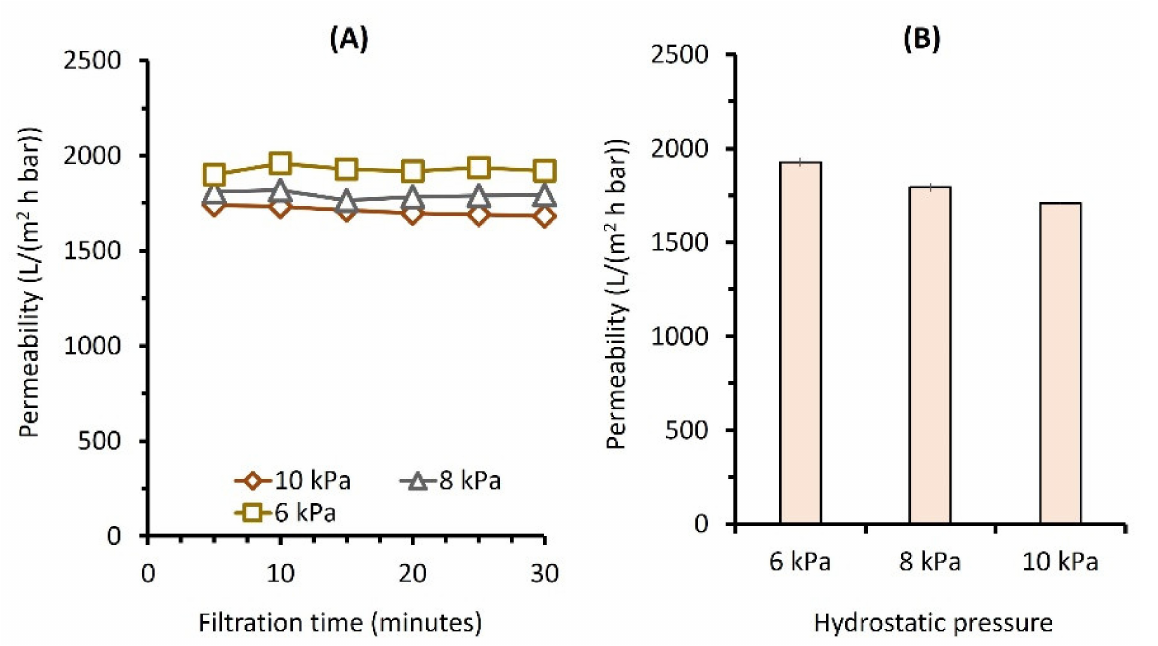
Figure 3. Filtration of detergent solution as a function of applied pressure shown ( A ) over time and ( B ) the final